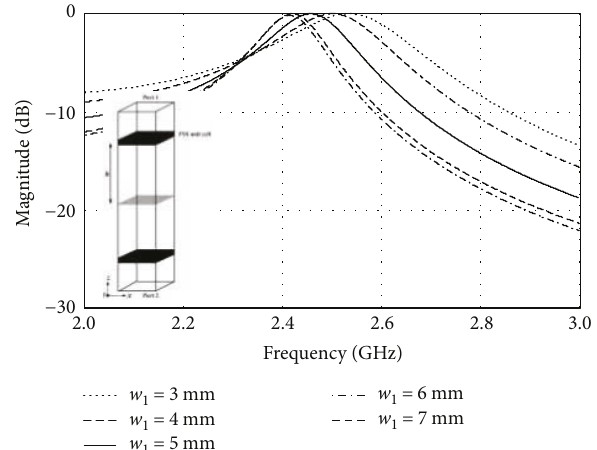
Figure 5: The simulated magnitude of the total transmission coe ffi cient of the modi fi ed FSS for various w